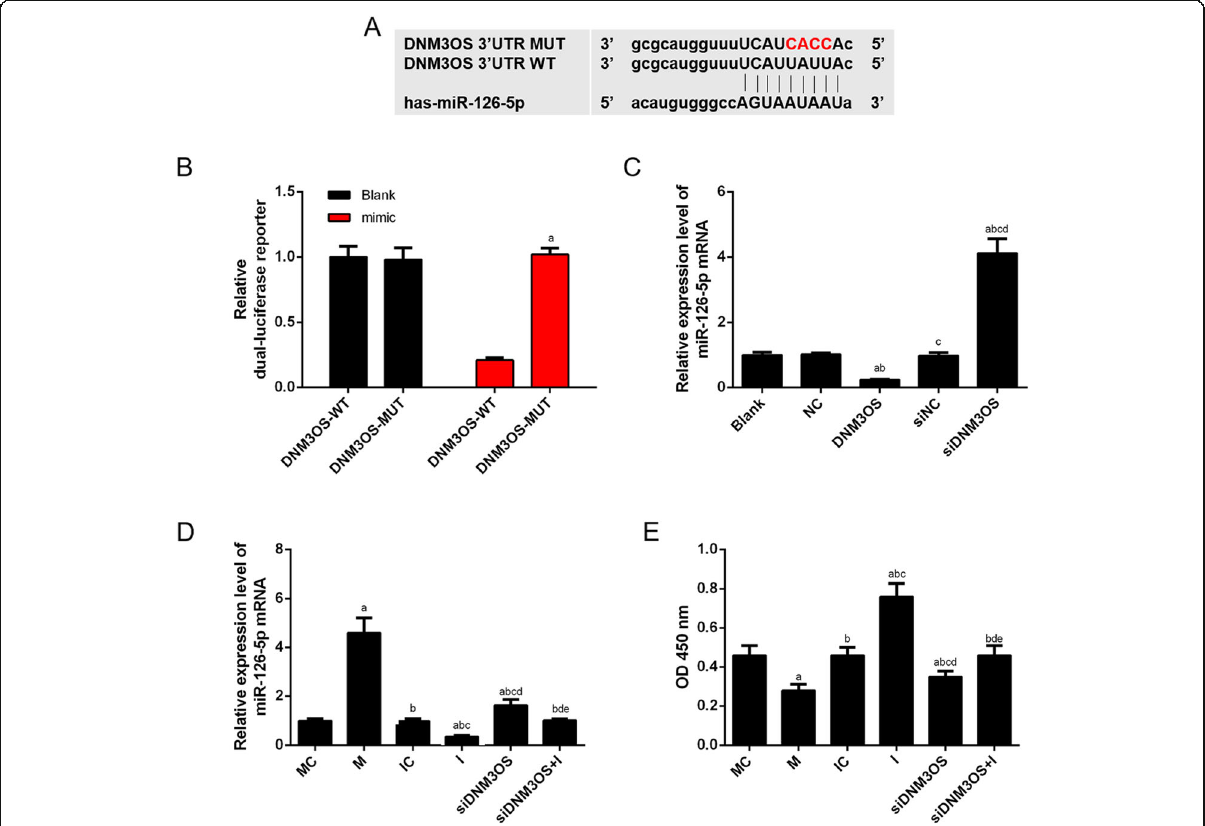
Fig. 4 LncRNA DNM3OS acted as a molecular sponge of miR-126. ( a ) The predicted binding sequences of miR-126 in DNM3OS using starBase v2.0. ( b ) The luciferase intensity of cells transfected with DNM3OS wild-type and miR-126 was significantly reduced. ( c ) The expression of miR-126- 5p was negatively associated to DNM3OS in CHON-001 cells by RT-qPCR. ( d ) MiR-126-5p inhibitor reversed the promotion effects of siDNM3OS on miR-126-5p level as indicated by RT-qPCR. ( e ) The inhibitory effects of siDNM3OS on cells viability were weakened by miR-126 inhibitor. a P <0.05 vs. DNM3OS-WT or Blank or MC, b P <0.05 vs. NC or M, c P <0.05 vs. DNM3OS or IC, d P <0.05 vs. I, e P <0.05 vs. siDNM3OS. WT: wild-type; MUT: mutated-type; NC: negative control; mimic: miR-126 mimic; M: miR-126 mimic; I: miR-126 inhibitor; MC: miR-126 mimic control; IC: miR-126 inhibitor control; siDNM3OS: small interfering dynamin 3 opposite